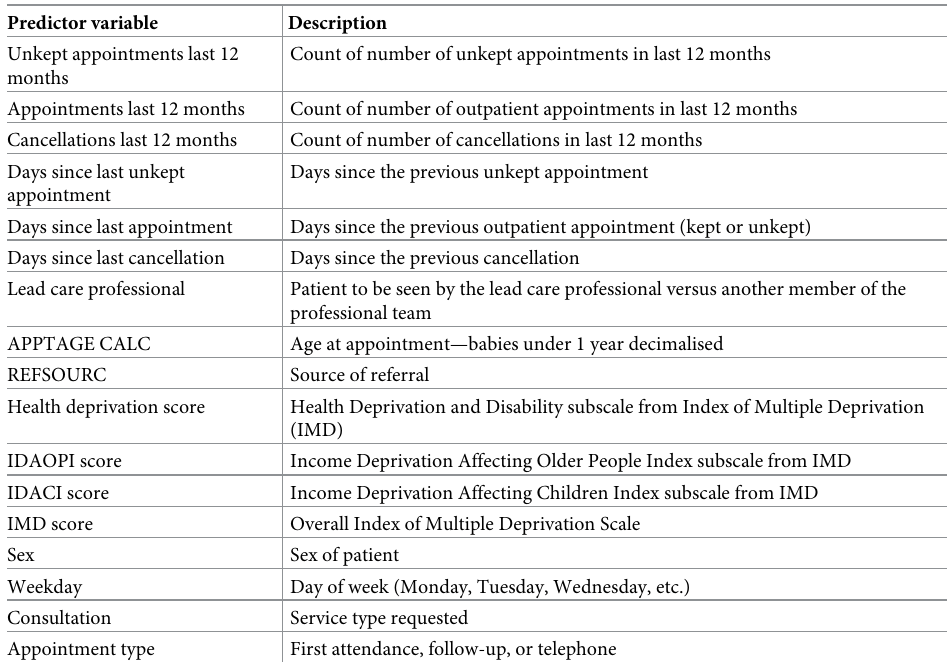
Table 1. Predictor variable